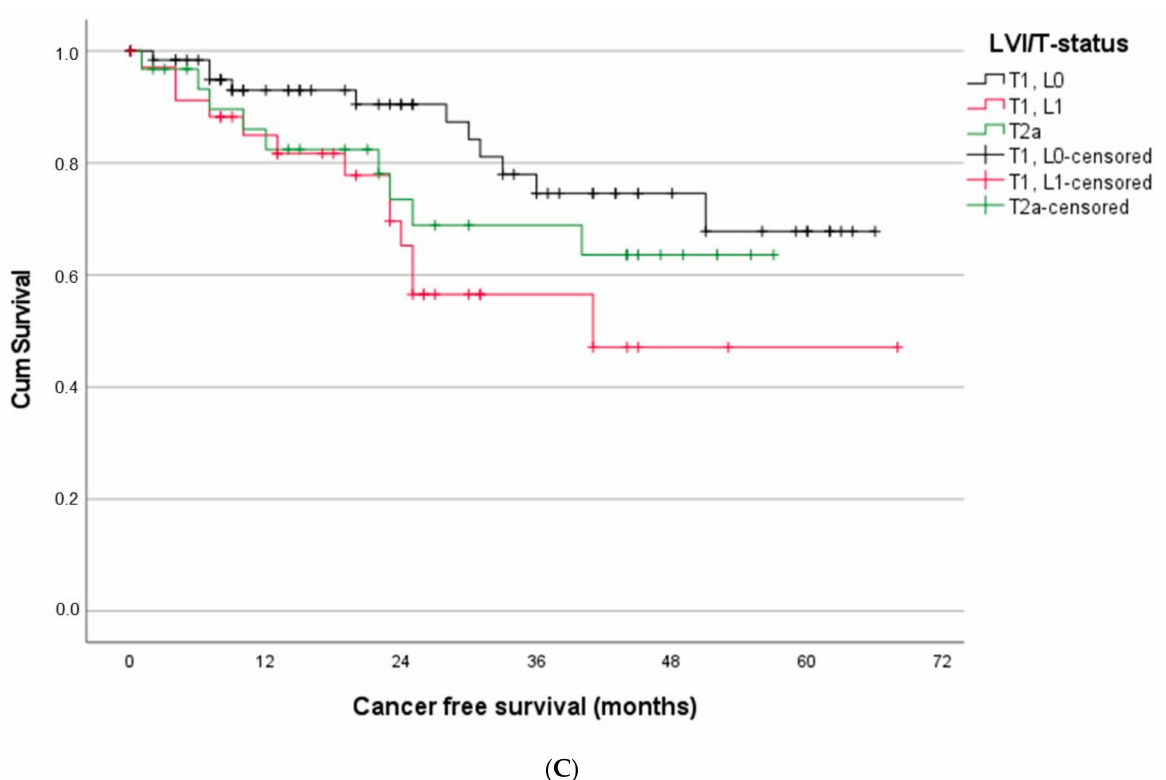
Figure 4. ( A ) Patients suffering from stage I/L1 had a similar outcome as stage II patients. ( B ) Patients with stage II/L1 and stage III showed a similar outcome, whereas stage II L0 patients had significantly better outcome than stage III patients. ( C ) Stage I patients with T1L1 showed significantly worse prognosis compared to T1L0 patients and, in the long run, also compared to patients with T2a. Analogous results were found when comparing survival curves of stage II and stage